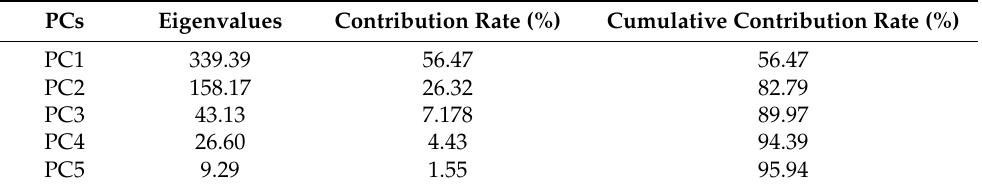
Table 3. Eigenvalues, contribution rates, and cumulative contribution rates of each principal component.